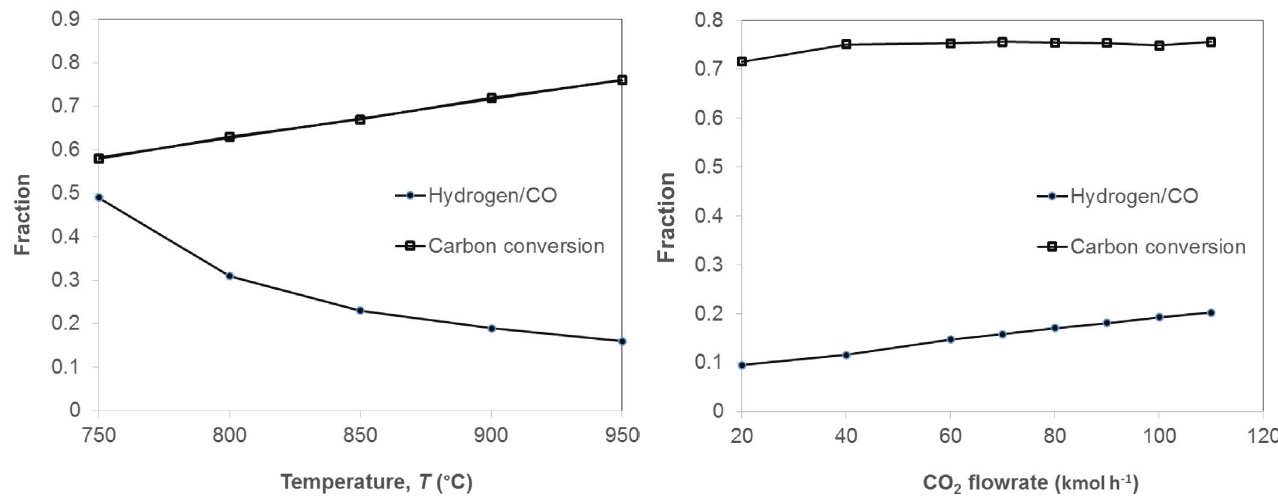
Fig. 3 – Effect of gasifying agent CO flow rate on syngas 2 quality and carbon